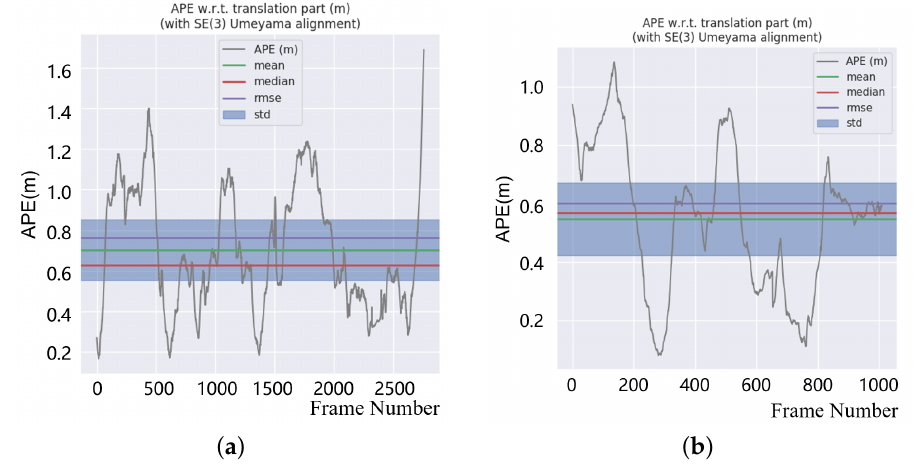
Figure 9. APE result on KITTI sequence 05 and sequence 07. ( a ) KITTI05 APE result and ( b ) KITTI07 APE result.